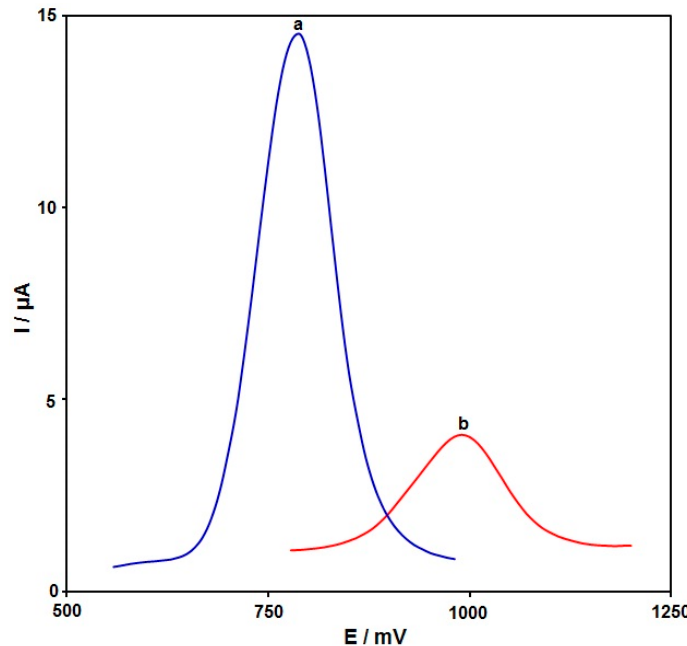
Figure 5. DPV recorded for (a) the PPy NTs/GSPE and (b) the un-modified GSPE in 0.1 M PBS at pH = 7 with 100.0 μ M hydroxylamine at a 50-mV/s scan